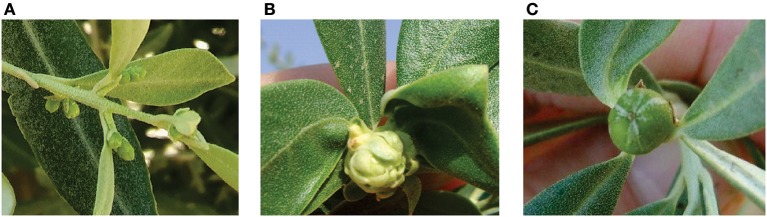
Deformed floral buds and fruit from olive trees exposed to insufficient chilling temperatures and high temperature events. Photograph (A) is from the olive collection at INTA-San Juan (31°S, Argentina); photographs (B,C) are from semi-tropical regions of Brazil, 22°-23°S (courtesy of Dr. Shimon Lavee).